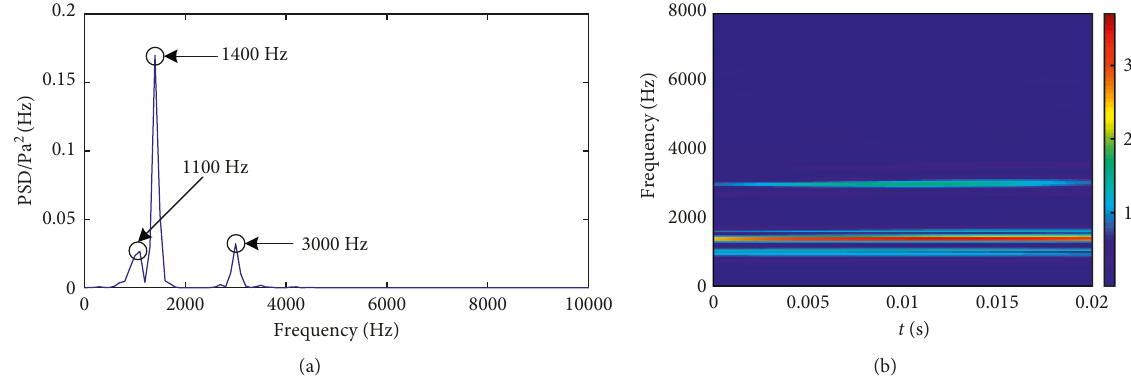
Figure 14: Calculated combustion noise of internal combustion engine at 800rpm and no-load condition. (a) Spectrum and (b) time- frequency